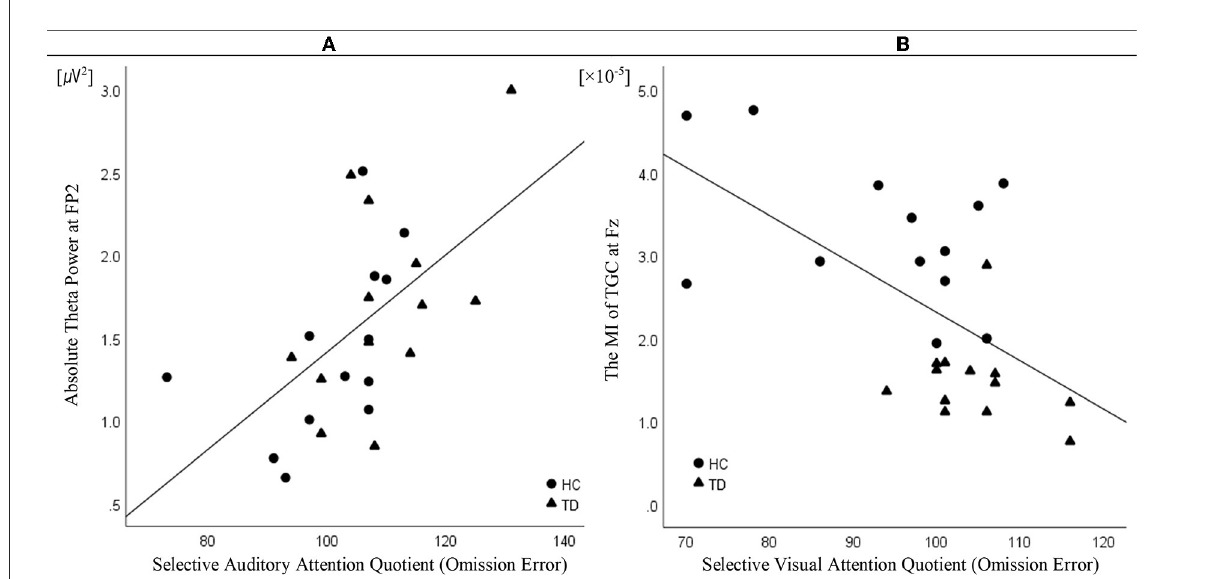
FIGURE3 Correlation (linear fit) (A) between absolute theta power at FP2 in the resting state and the attention quotients (AQ) of omission errors (OEs) for selective auditory attention in patients with tic disorder and healthy children ( n = 26, R 2 linear = 0.42, p = 0.043) and (B) between the modulation index of theta–gamma coupling at Fz during the resting state and the AQ of the OEs for selective visual attention in patients with tic disorder and healthy children ( n = 26, R 2 linear = 0.43, p =